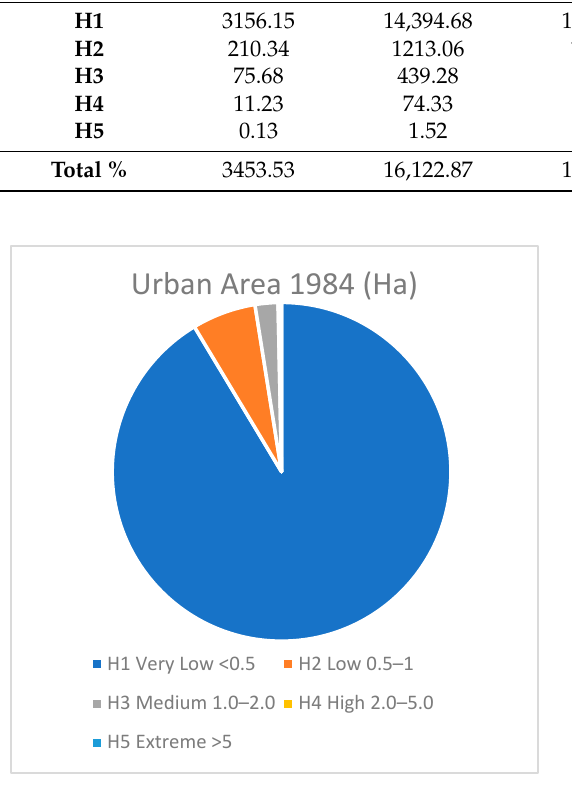
Figure 14. Distribution of urban areas exposure over hazard classes for 1984.